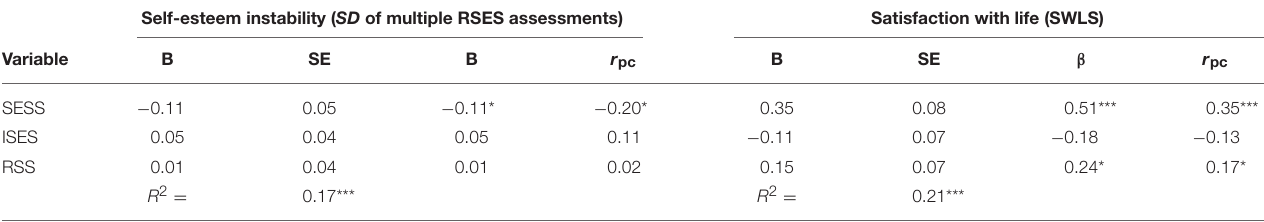
SWLS, Satisfaction With Life Scale; SESS, Stability of Self-Esteem Scale; ISES, Instability of Self-Esteem Scale; RSS, Rosenberg Stability of Self Scale; r pc , partial correlation between predictor and criterion controlling for the other predictors, respectively. Correlations of self-esteem instability with direct measures were for SESS r = − 0.40, for ISES r = 0.36, and